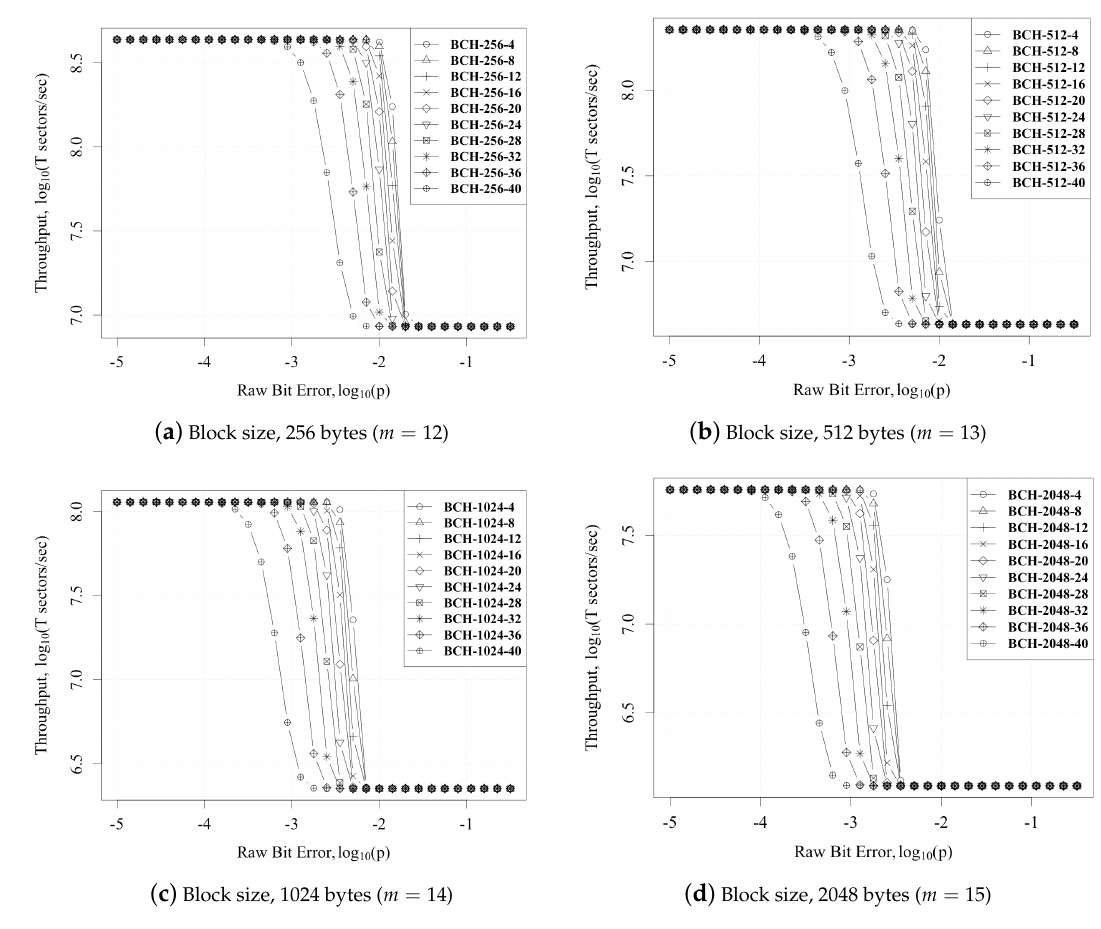
Figure 9. Raw bit error vs. throughput